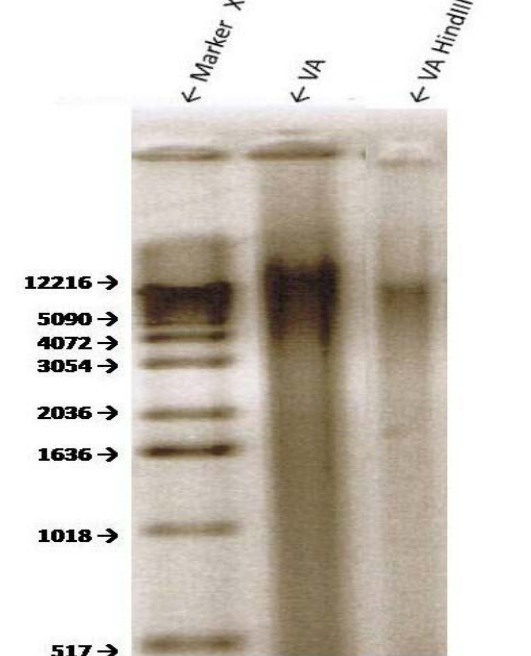
Figure 5 : Genomic DNA digestion of VA with restriction enzyme Hind III. Agarose gel electrophoresis of genomic DNA samples of VA and spinach were digested with restriction enzyme Hind III. Hind III cuts at recognition sequence A ↓ AGCTT.